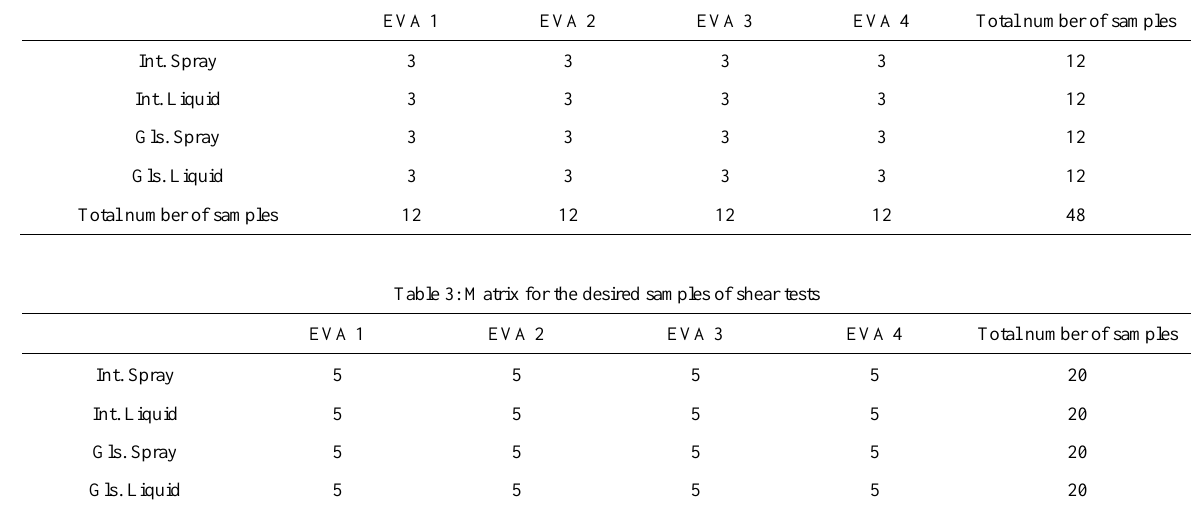
Table 2: Matrix for the desired samples of durability tests